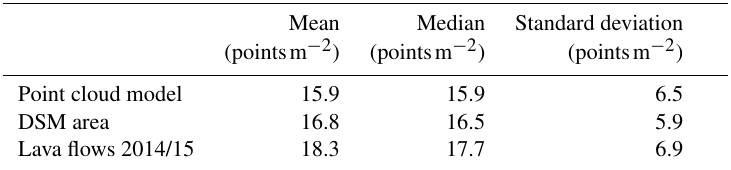
Figure 8. Example of manual delineation of the lava flow by making use of the (a) orthomosaic, (b) elevation contours with 50cm intervals, (c) hill shade model, and (d) hill shade model and elevation contours. Table 2. Point density in selected areas of the Chã das Caldeiras point